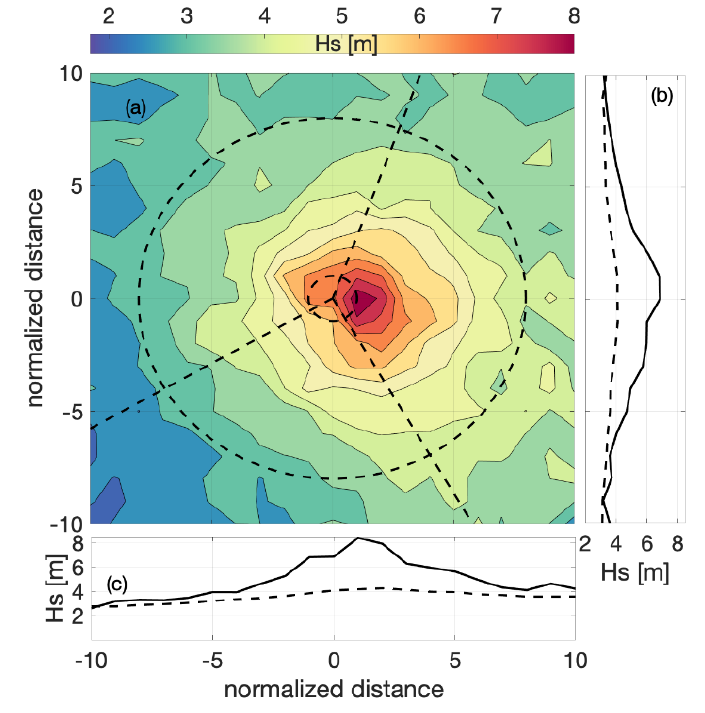
Figure 3. Average wave height observed by altimeters in a TC-centered reference frame (Ur ≥ 33 m/s). ( a ) Color scale indicates average wave height observed in 2R × 2R bins, with contour lines every 0.5 m. Small dashed circle is R = 1; larger dashed circle is R = 8. Dashed lines show TC sectors according to [27]. Up arrow is the orientation of the TC, moving forward up the page. ( b ) Solid line is a back to front transect along nX = 0 and the dashed line is the average along the nX axis. ( c ) as in ( b ) for nY. Figure 3 is referenced in Section 3.1 The corrected text now states: The wave heights are asymmetric with the highest wave heights in the right sector around R = 1. The left to right asymmetry is pronounced, at R = 5, there is a ~1.5 m differ- ence between the wave height in the right and left sectors along the nY = 0 transect (Figure